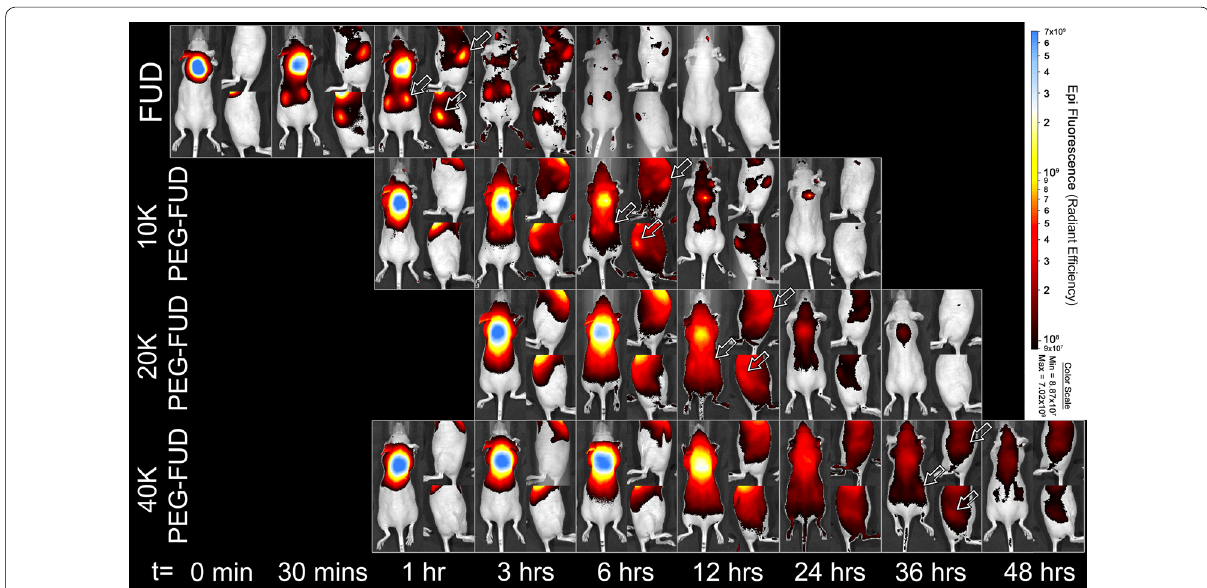
Fig. 10 Posterior and lateral views of mice show increased and earlier FUD and PEG-FUD signal in the kidney region for lower MW peptides. A single dose containing a peptide and its sulfo-Cy5 conjugate counterpart was injected s.c. between the shoulder blades of a mouse. Arrows indicate apparent maximal peptide kidney